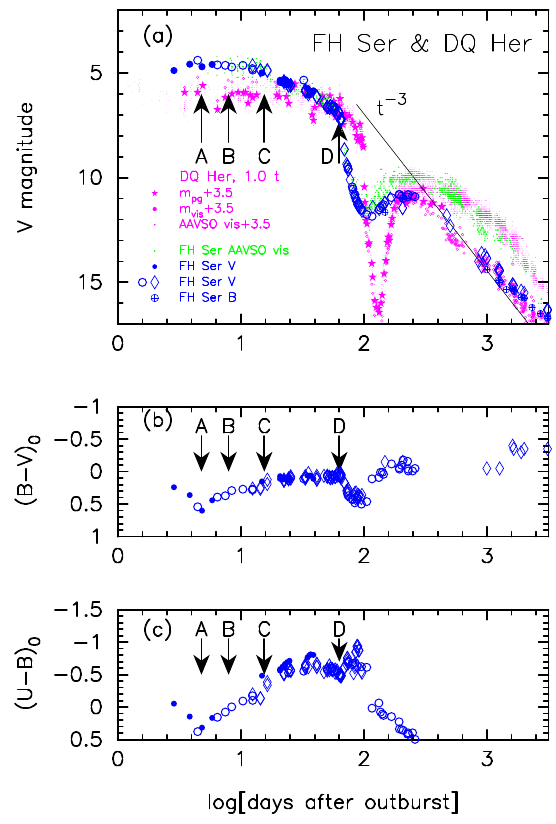
Figure 1: Light and color curves of FH Ser